Question: Give a one-sentence summary of this figure.
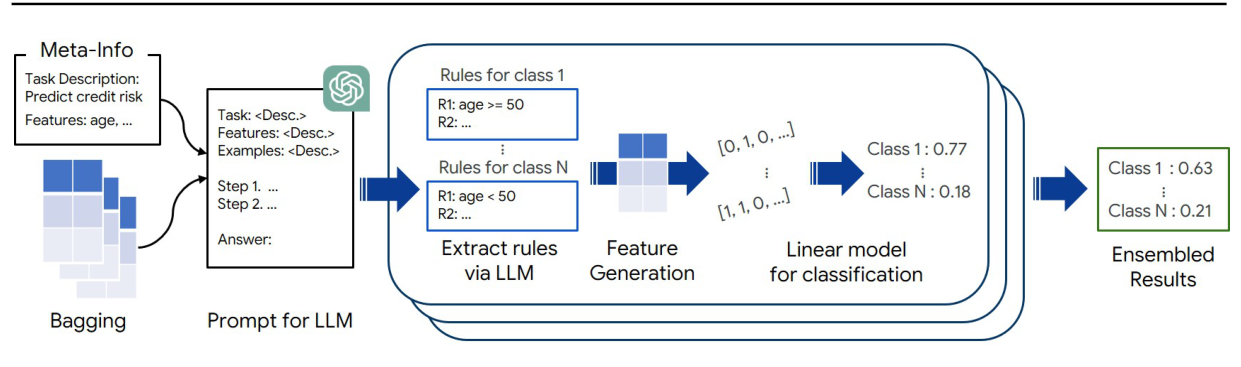
Answer: Illustration of FeatLLM. FeatLLM extracts rules for each class, utilizing prior knowledge and few-shot examples. These rules are then parsed and applied to create binary features for data samples. A linear layer is trained on these binary features to estimate class likelihoods. This procedure is repeated multiple times for ensembling.